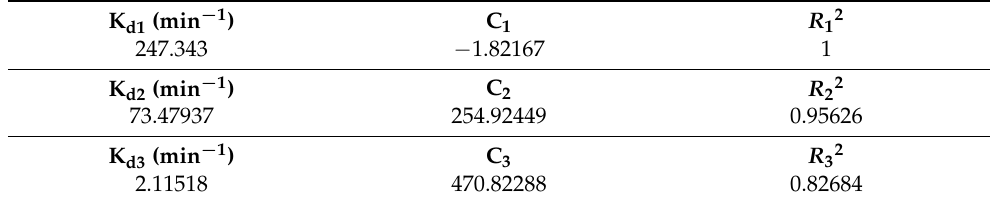
Table 11. Intra-particle diffusion model constants and correlation coefficients for adsorption of